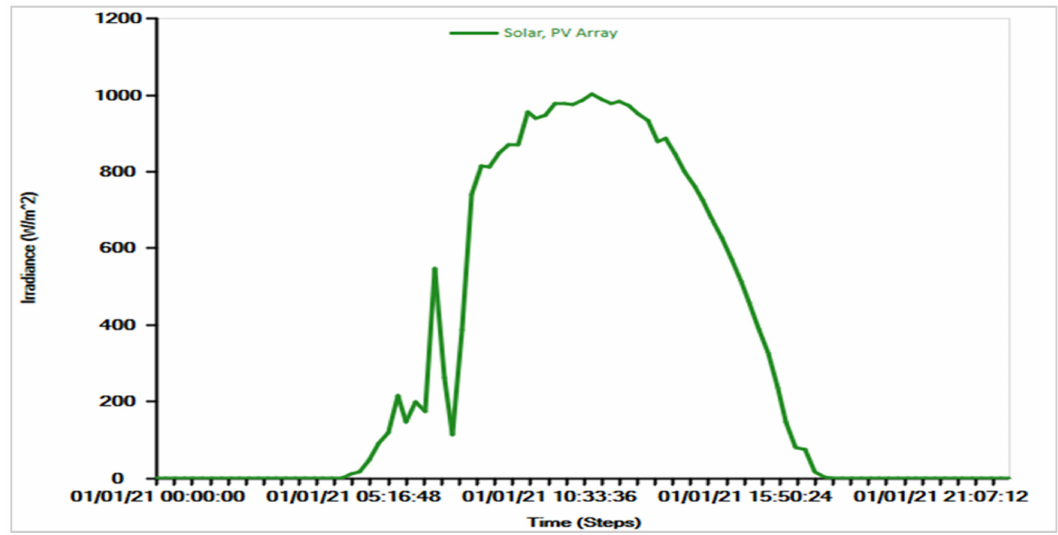
Figure 6. Photovoltaic irradiance.